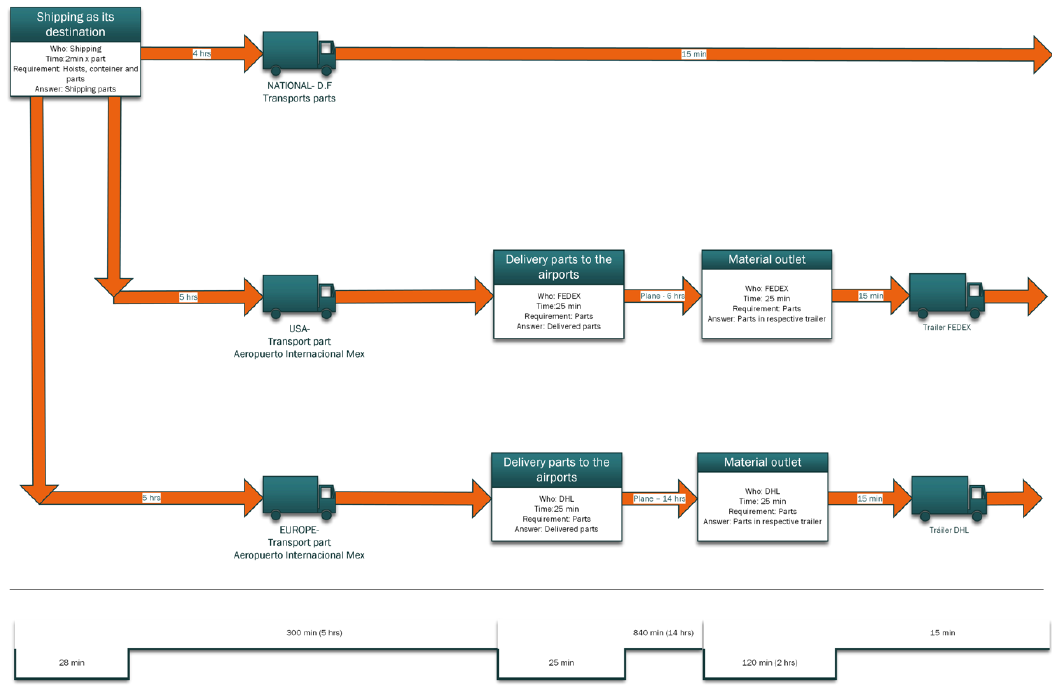
Figure 14. The fifth part of seven of the Current State Value Stream Map with wastes.